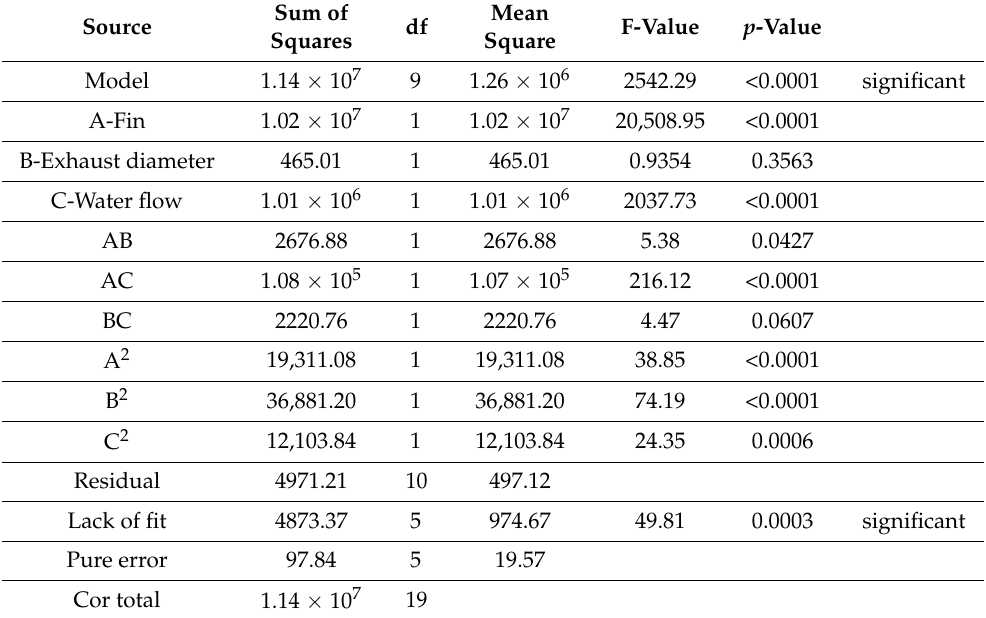
Table 6. Results of ANOVA for the HTR response.